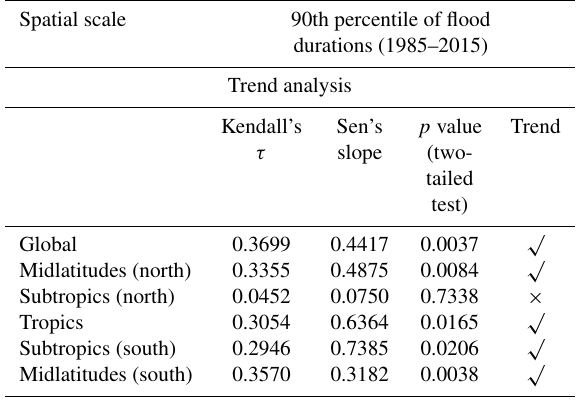
Table 6. Same as Table 2 but for the 90th percentile of flood dura- tion